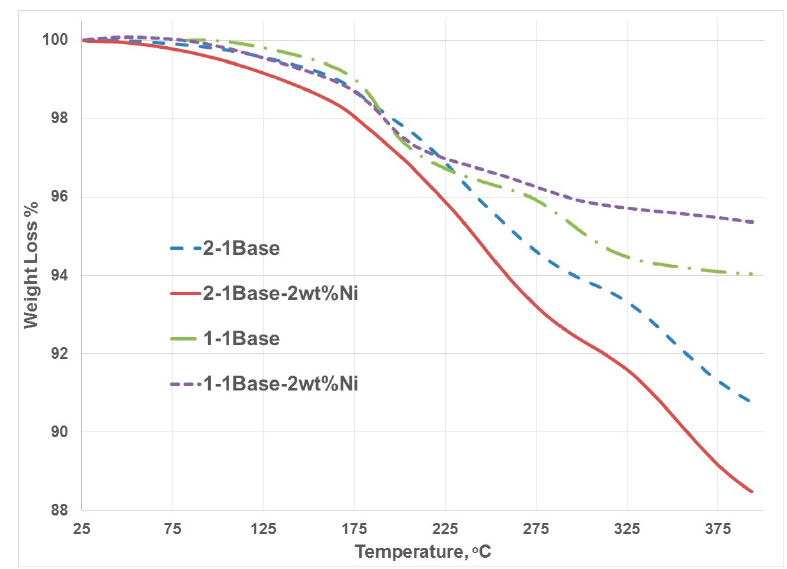
Figure 1. Thermogravimetric analysis (TGA) profiles of pristine and Ni-doped LiNH 2 -nanoMgH 2 with 1:1 and 2:1 ratios.